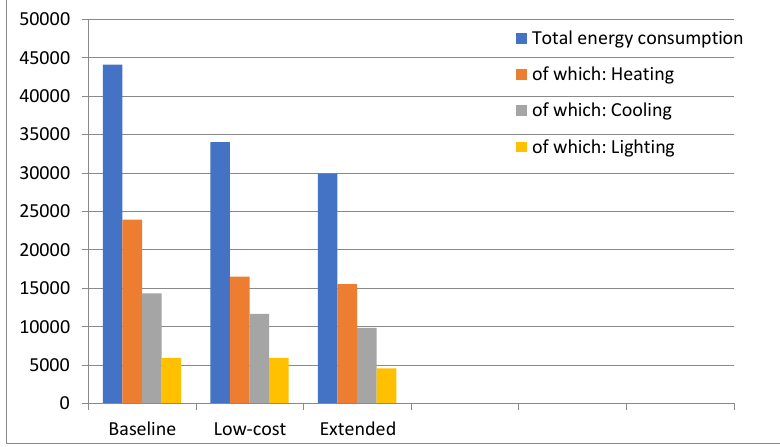
Figure 3. Annual energy consumption for heating, cooling and lighting; case of Stuttgart (kWh). Table 5. Energy savings from home automation.